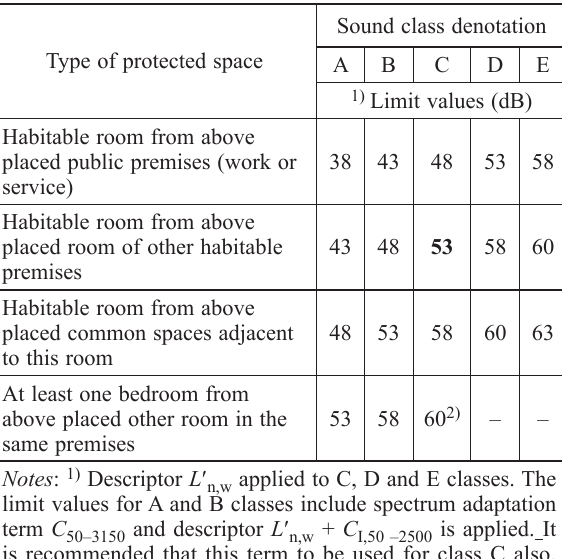
Table 6. The requirements of impact sound insulation established for horizontal partitions (floors) between adjacent premises in dwellings, as the maximal limit values of each sound class (STR